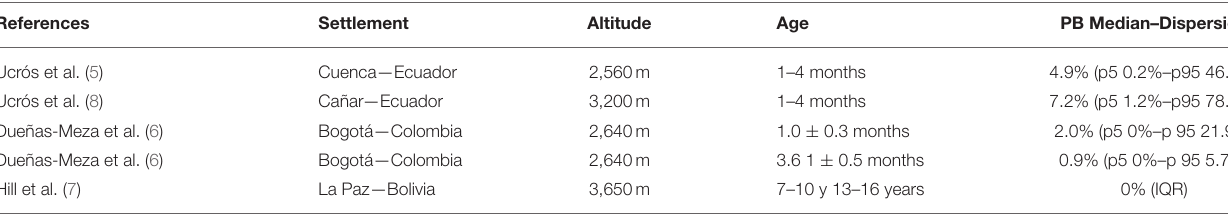
TABLE 4 | Periodic breathing (PB) values according to altitude and